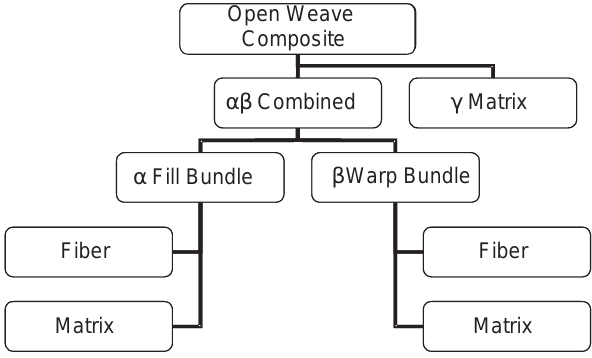
Fig. 1. Hierarchy of metrical decomposition of a plain weave, woven fabric